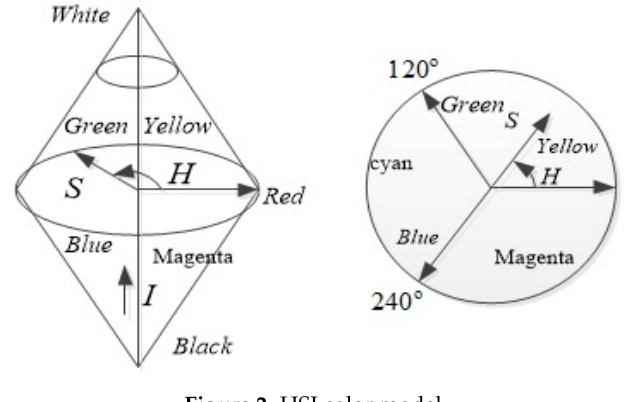
Figure 2. HSI color model.